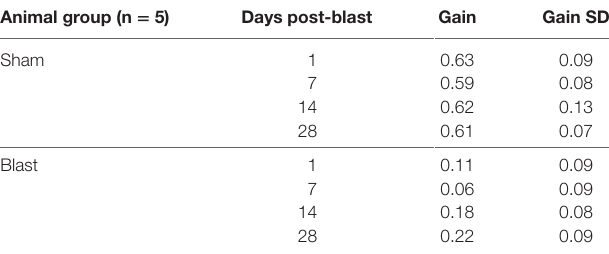
TaBle 2 | Mean OKN gain values for control and post-blast animals. animal group (n = 5)